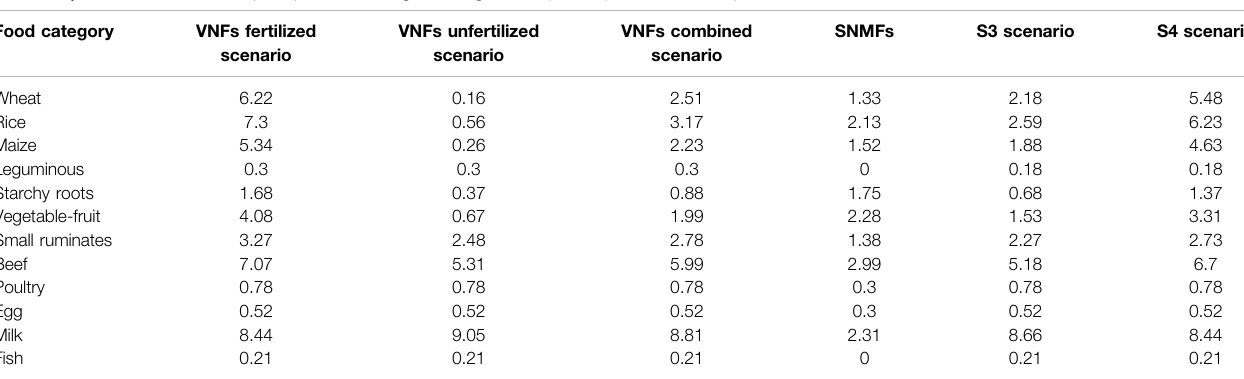
TABLE 3 | Mean virtual N factors (VNFs) and soil nitrogen mining factors (SNMFs) of various food products under different scenarios in Rwanda. Food category VNFs fertilized